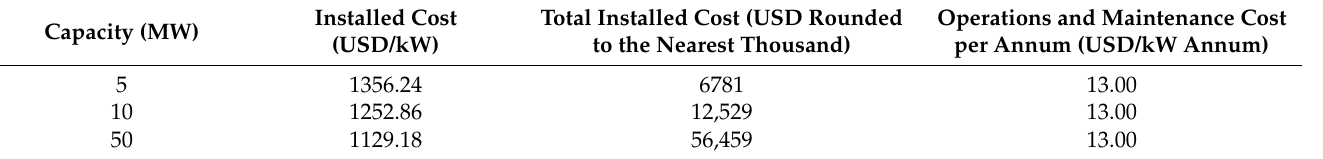
Table 4. Input cost data